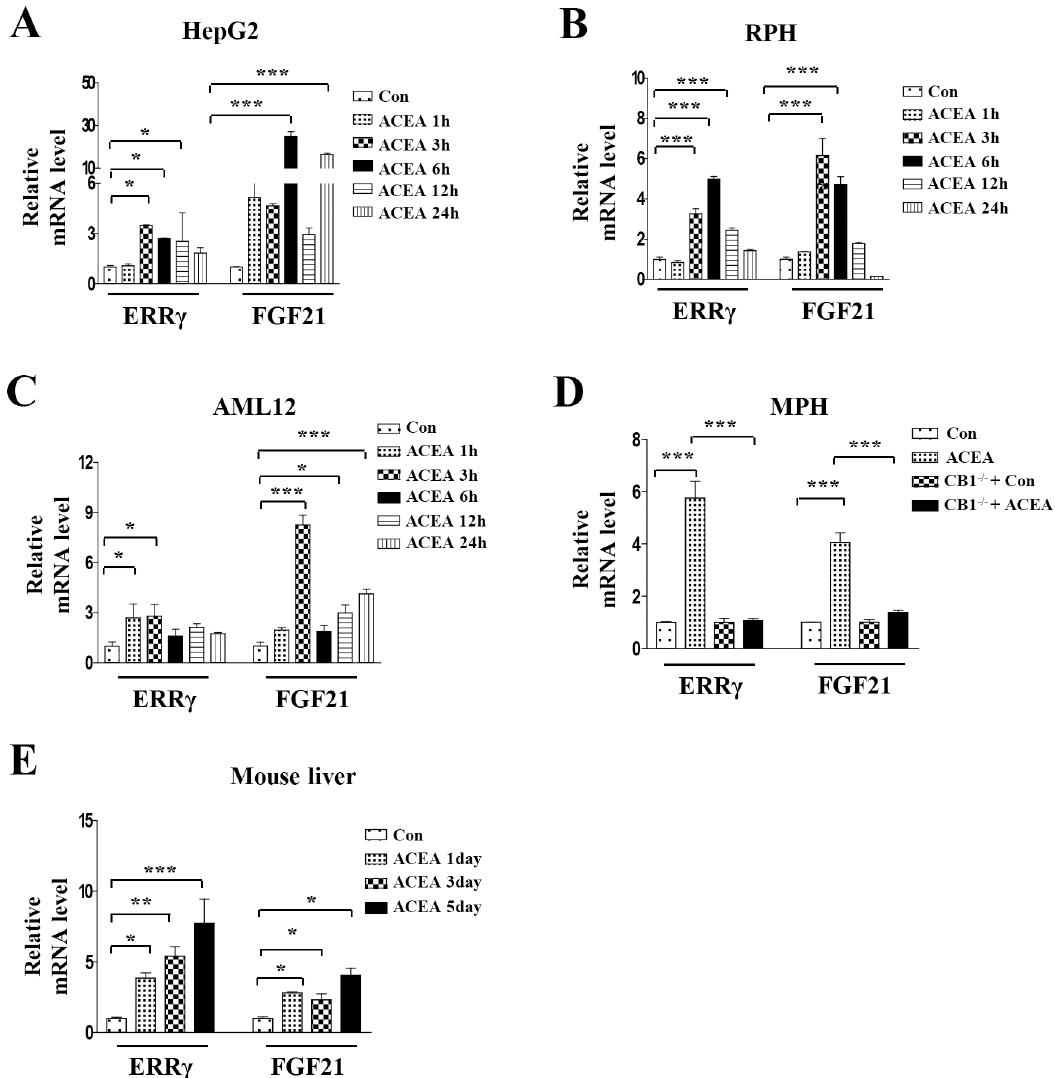
Fig 1. ACEA induces FGF21 gene expression. (A – C) HepG2 cells, rat primary hepatocytes (RPH), and AML12 cells were treated with ACEA (10 μ M) for the indicated time periods. (D) Wild-type or CB1 -/- mouse primary hepatocytes (MPH) were treated with ACEA (10 μ M) for 3 h. (E) Mice were treated with ACEA (10 mg/kg) for the indicated number of days. Livers were harvested for mRNA analysis. (A – E) FGF21 and ERR γ mRNA levels were measured by quantitative qPCR analysis and normalized to actin mRNA levels. All data are the means ± standard errors of at least three independent experiments. * p < 0.05; ** p < 0.01; *** p < 0.001 by one-way